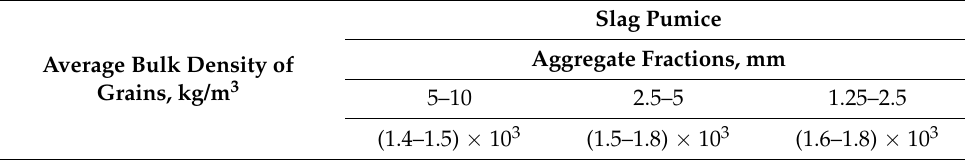
Average Bulk Density of Grains, kg/m 3